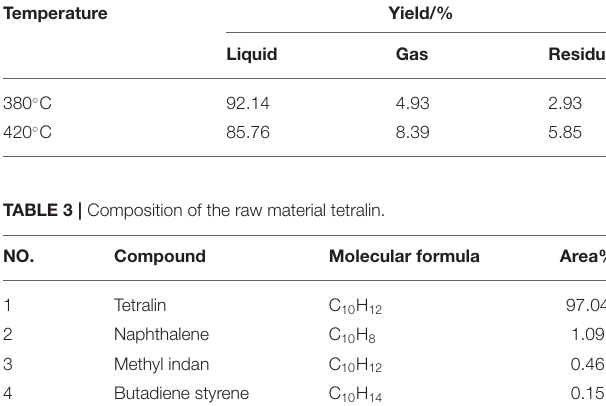
TABLE 4 | Relative content of hydrocarbons in liquid products.